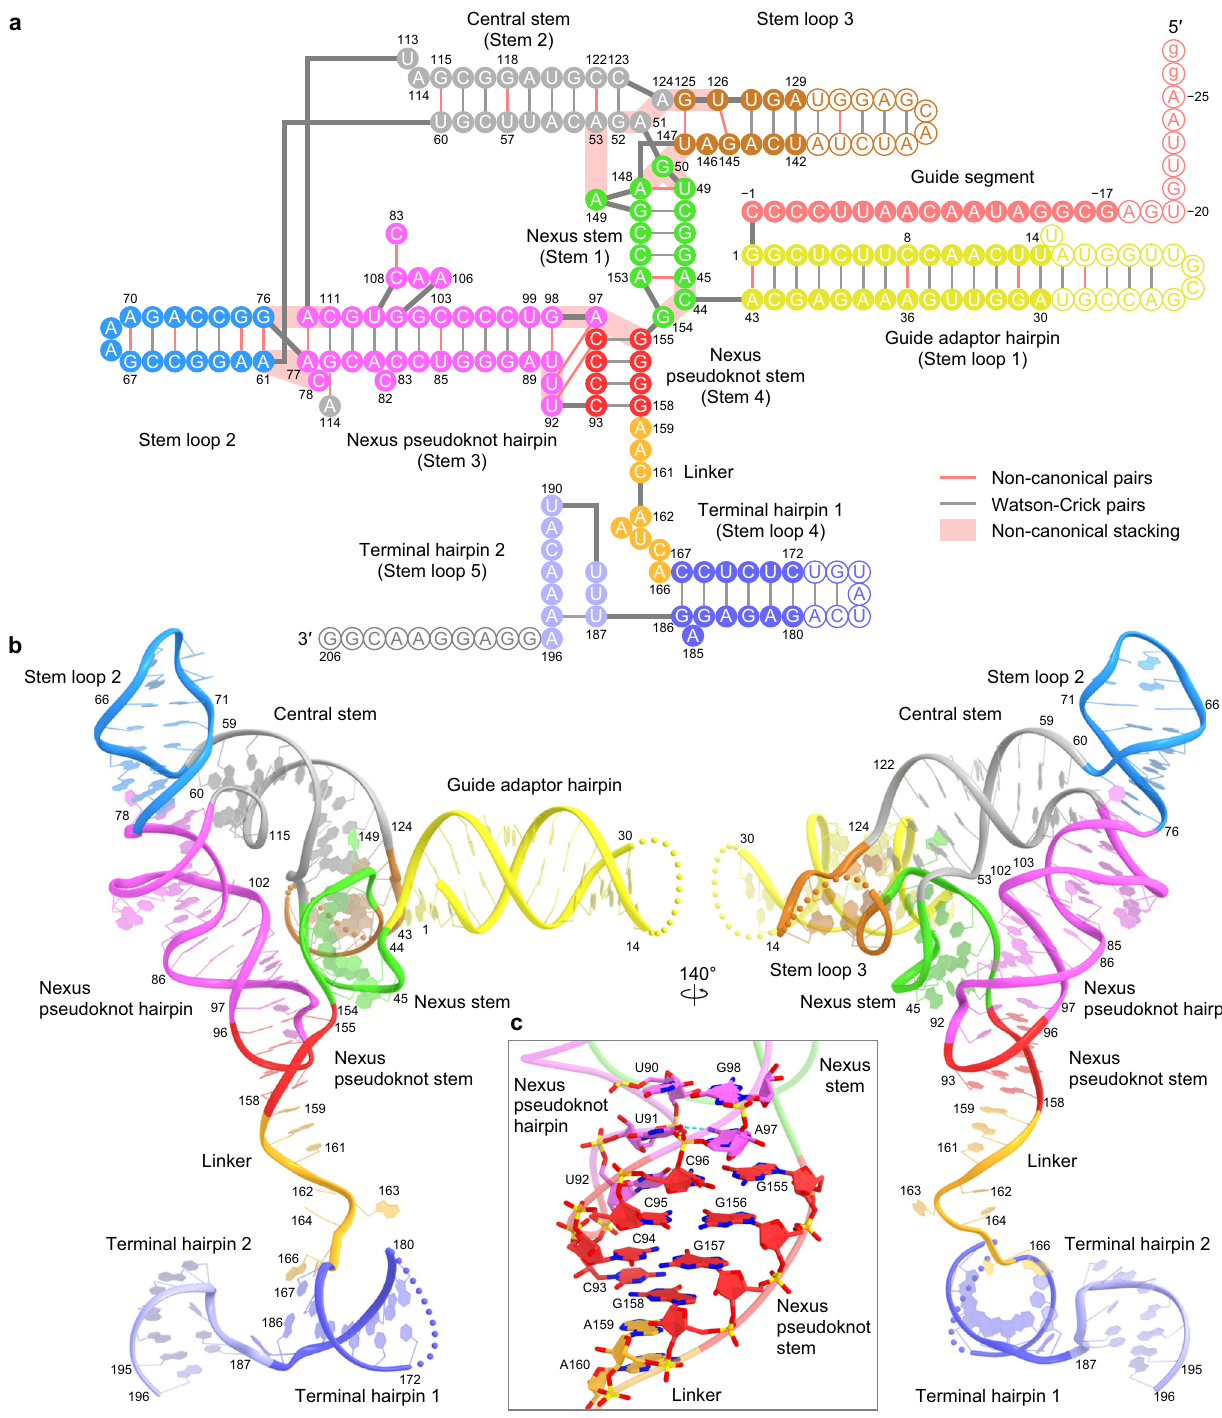
Fig.3| ω RNAarchitecture.a , b Schematic( a )andstructure( b )ofthe ω RNA.Disorderednucleotidesareindicatedbycircleswithwhitebackgroundsin a anddottedlines in b . c Close-up view of the nexus pseudoknot